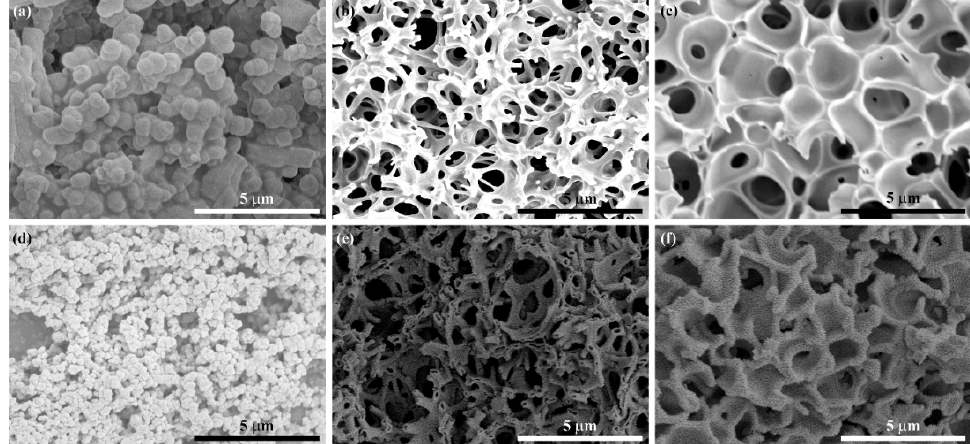
Figure 4. SEM image of ( a ) Co 2 Sn(OH) 6 -1, ( b ) Co 2 Sn(OH) 6 -2, ( c ) Co 2 Sn(OH) 6 -3, ( d ) Co 2 SnO 4 -1, ( e ) Co 2 SnO 4 -2, and ( f ) Co 2 SnO 4 -3.